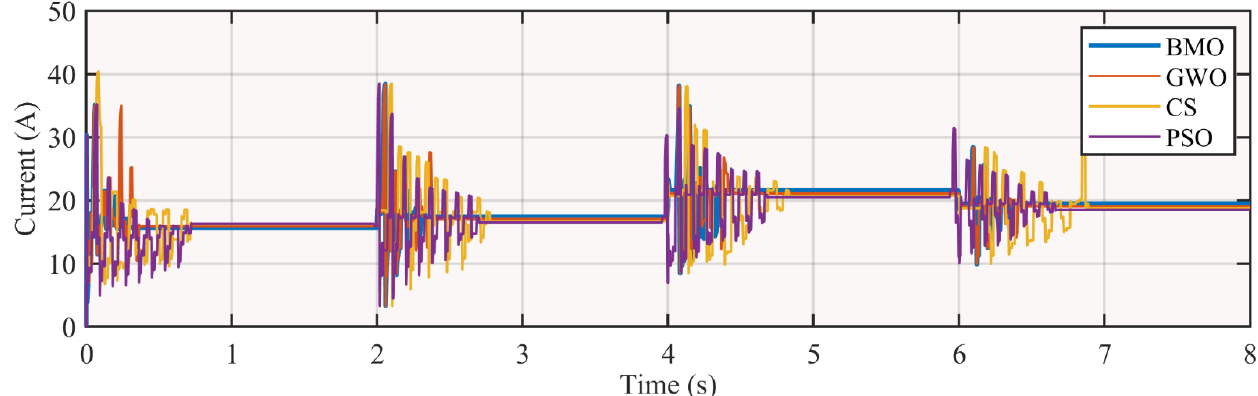
Figure 21. Competing techniques current Case-2.